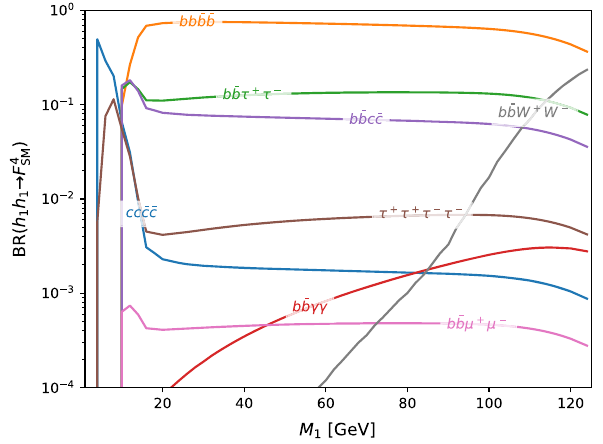
Fig. 12 Branching ratios of the h 1 h 1 state of BP4 and BP5 into selected SM decay modes as a function of M 1 ¯ ¯ bb b is dominant, followed by b into b M 1 the predominant decay is into charm